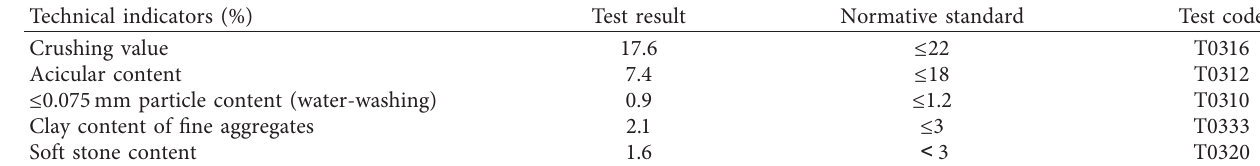
Table 2: Technical performances of the